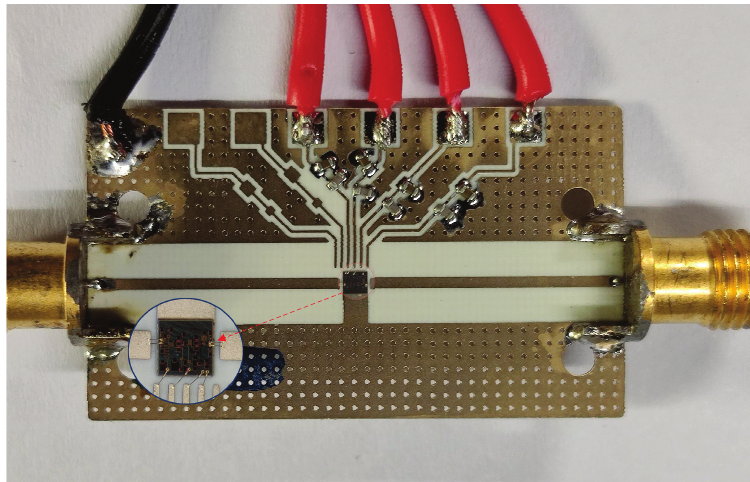
Figure 9. Photograph of the implemented broadband driver